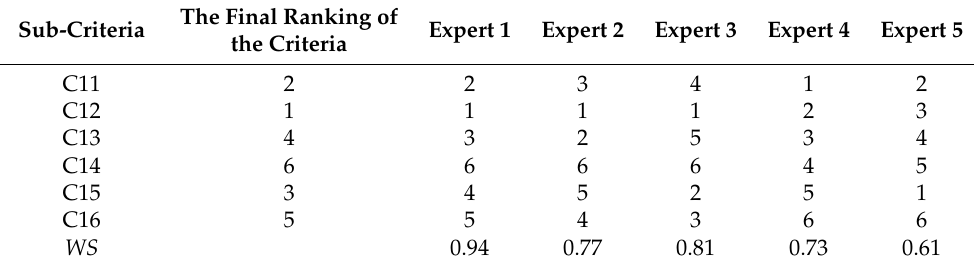
Table 8. The WS coefficients of the sub-criteria of C1.